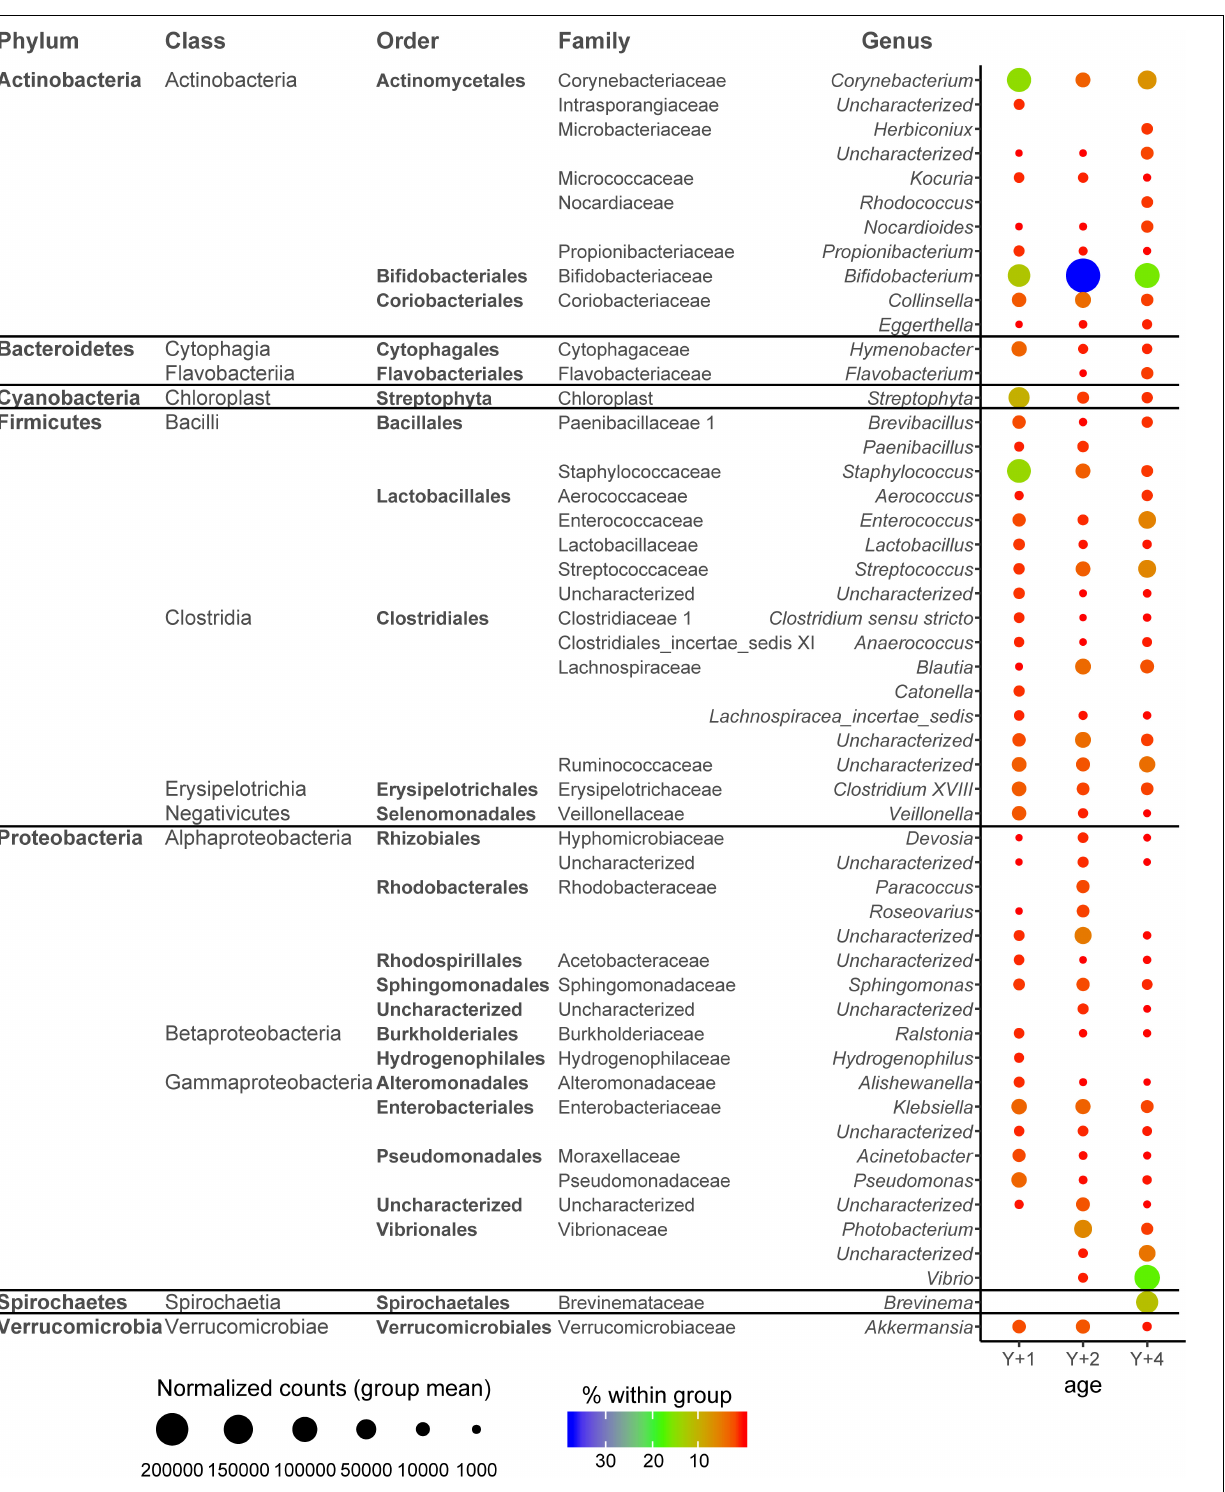
FIGURE 3 | Dotplot map depicting the genera with more than 2,500 normalized counts in at least one age group. The size of the dots represents the normalized counts in each group. The color scale represents the mean abundance, in percentage, of each genus within each group. Y + 1, Y + 2, and Y + 4 correspond to 1-, 2- and 4-year-old gilthead sea bream,